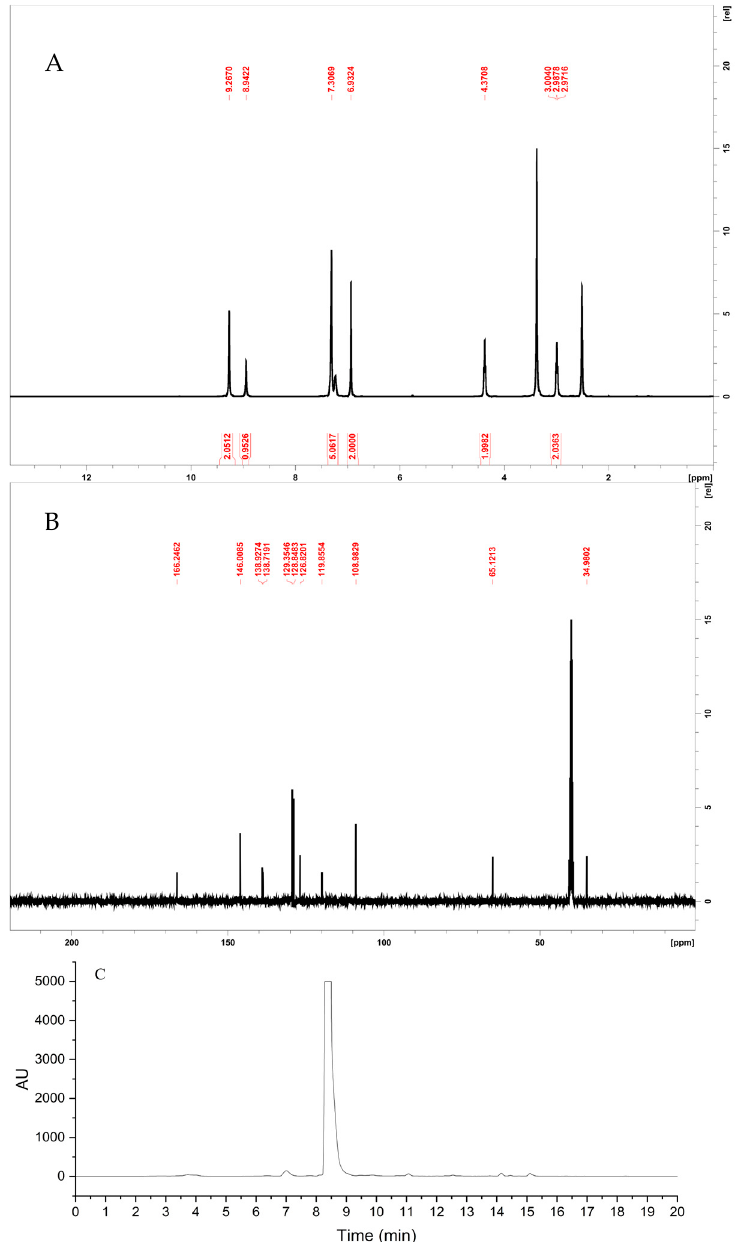
Figure 6. Characterization of PEGA. ( A ) 1 H − NMR spectra of PEGA. ( B ) 13 C − NMR spectra of PEGA. ( C ) HPLC chromatogram of